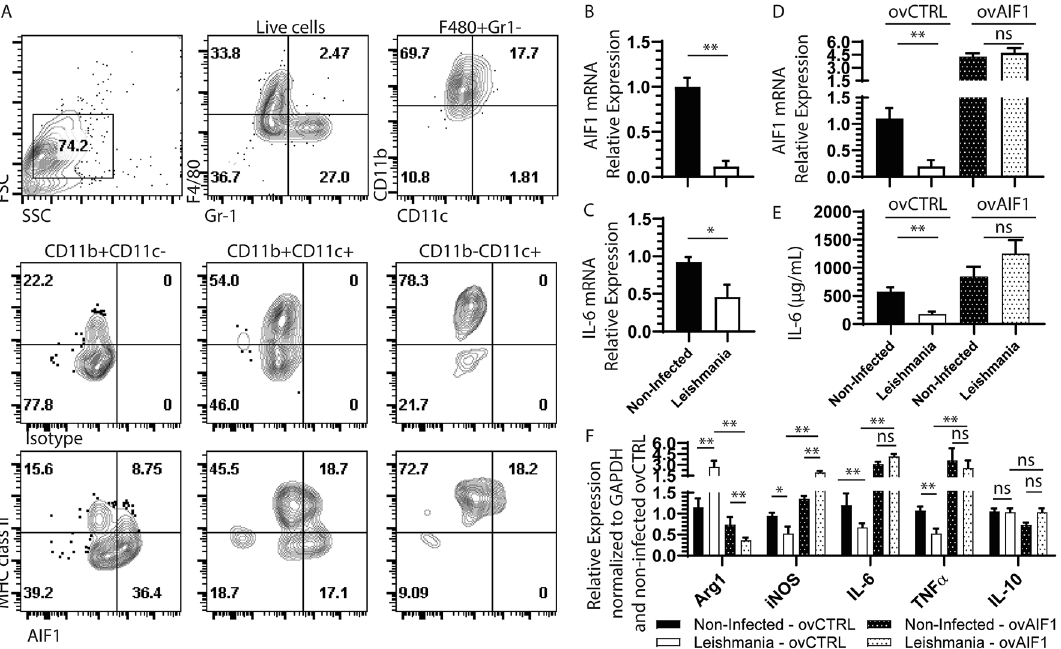
Figure 3. Bone marrow-derived macrophages (BMDM) express AIF1 under M-CSF stimulation. Bone marrow cells derived from wild type C57BL6 mice ( n = 8) were differentiated into macrophages after 6 days of M-CSF stimulation. Differentiated cells were stained with Gr-1, F4/80, CD11b, MHC class II, CD11c and AIF1 prior to acquisition on a flow cytometric analyzer. ( A ) F4/80 + Gr-1 neg cells were then assessed for expression of AIF1 in CD11b + CD11c neg , CD11b + CD11c + and CD11b neg CD11c + . Isotype controls were used to establish the gating strategy for all quadrants. ( B , C ) For transcriptional analyses AIF1 and IL-6 was assessed upon in vitro infection with L. donovani in BMDM. Real-time PCR data is normalized to respective non-infected group controls. ( D ) Plasmid containing an overexpression vector for AIF1 (ovAIF1) under a non-repressible promoter was transfected into BMDM prior to infection with L. donovani . An empty expression vector served as control (ovCTRL). ( E ) IL-6 ELISA assays were performed on supernatant collected from ovAIF1 versus ovCTRL transfected BMDM infected with L. donovani . ( F ) Real-time PCR studies were performed to assess macrophage transcriptional expression changes for Arg1, iNOS, IL-6, TNFα, and IL-10 upon overexpression of AIF1 after L. donovani infection. Data are representative of four independent experiments with three replicates per group per experiment. Data shown as mean ± SEM. Statistical significance was determined by unpaired t -test. * p < 0.05 and ** p <